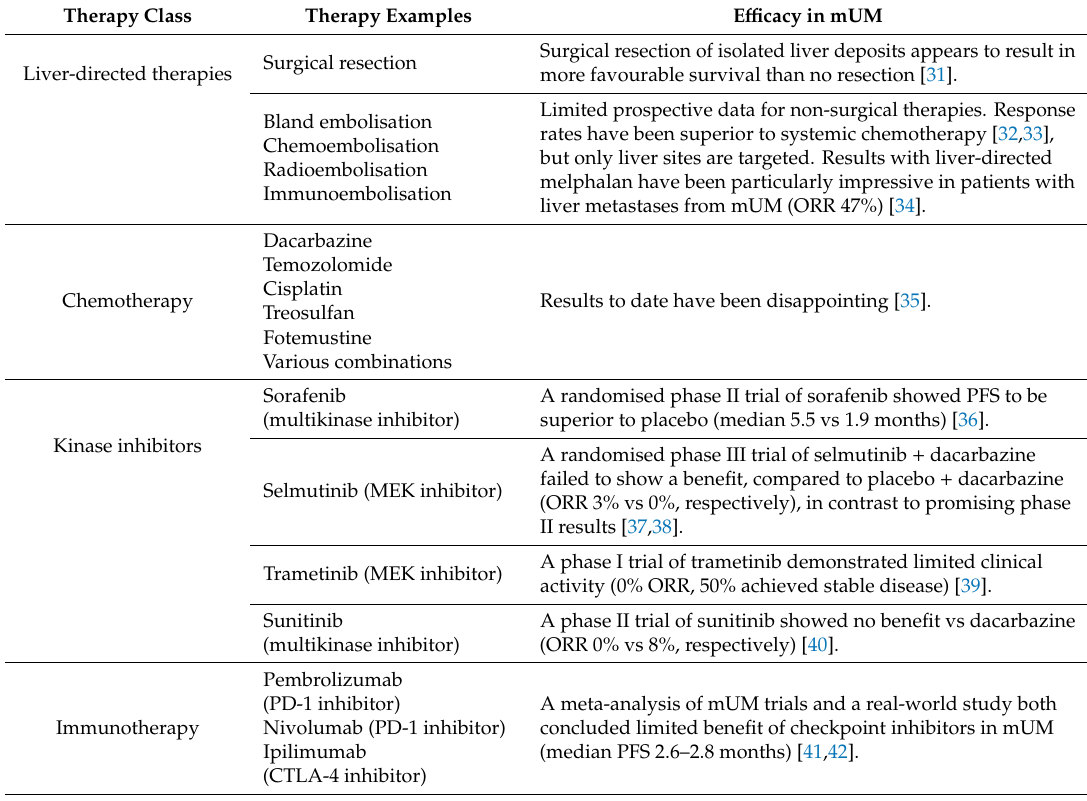
Table 1. Existing therapies for metastatic uveal melanoma